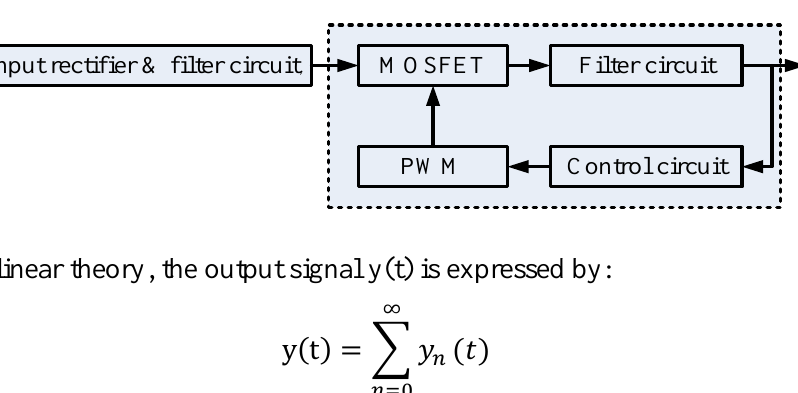
Figure 2. The SMPS topology